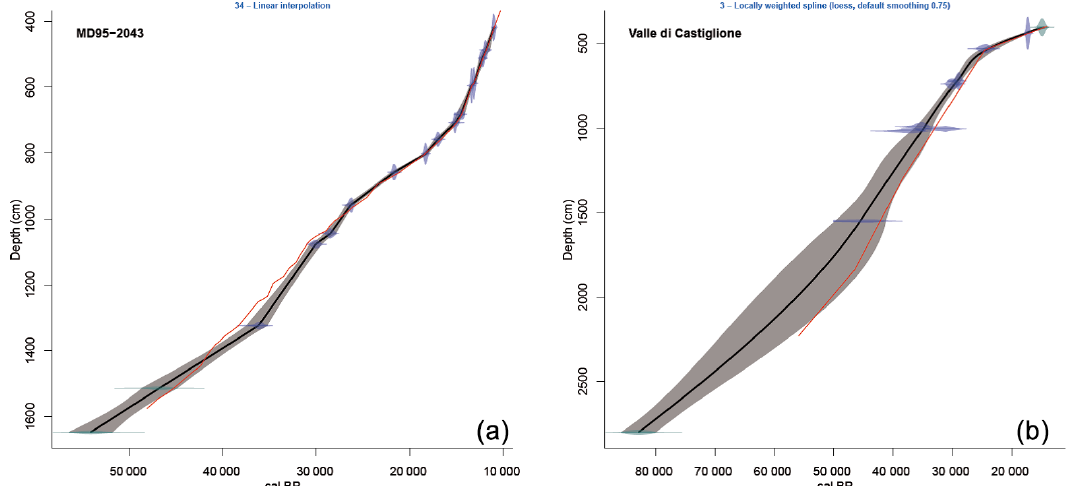
Figure 3. (a) Linear age model of the marine core MD95-2043 and (b) third-order polynomial age model of the terrestrial sequence Valle di Castiglione (Italy). Red line: original age model with the control points. Black line: harmonized age model based on radiometric dating and event stratigraphy. Blue: calibrated 14 C distribution. Green: non- 14 C age distribution (Ar / Ar, OSL, event stratigraphy). Grey shading: age uncertainties.